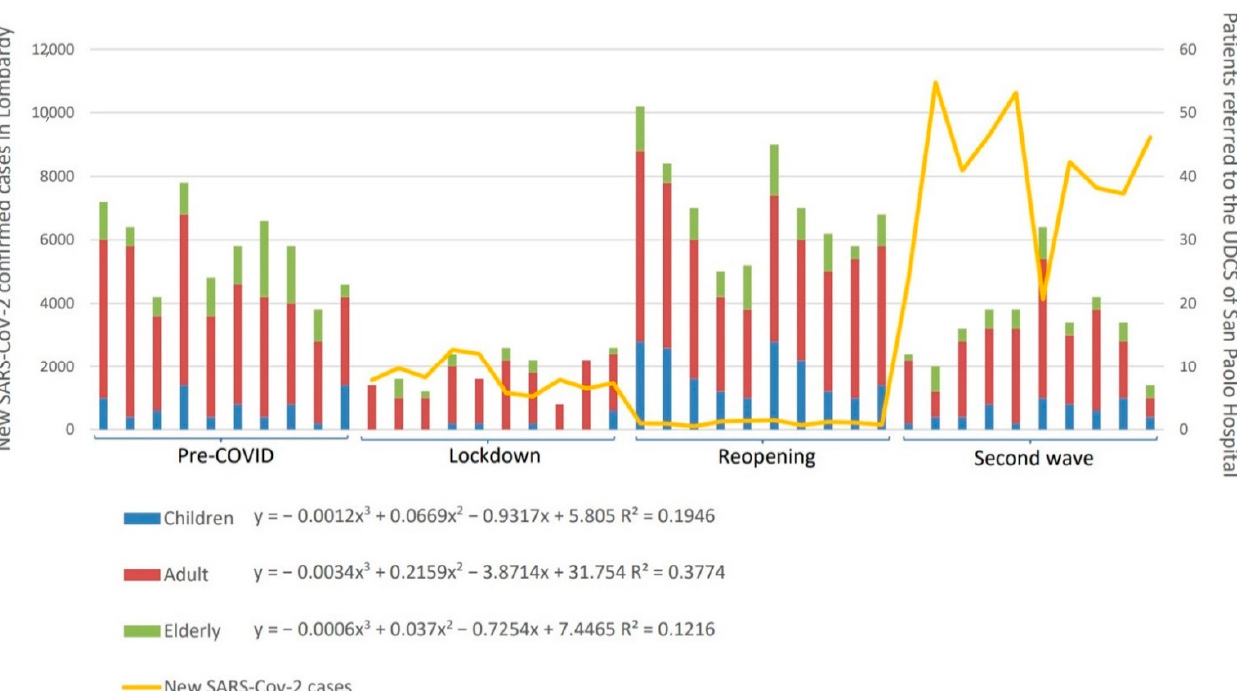
Figure 1. Curve of the number of patients visiting the Urgent Dental Care Service (UDCS) in the four time periods and new cases of SARS-CoV-2. Trend coefficient are reported for children ( ≤ 18 years), adults (19–65 years), and the elderly (>65 years). Table 1. Age and sex of patients attending the Urgent Dental Care Service (UDCS) of San Paolo Hospital in Milan during the four time periods